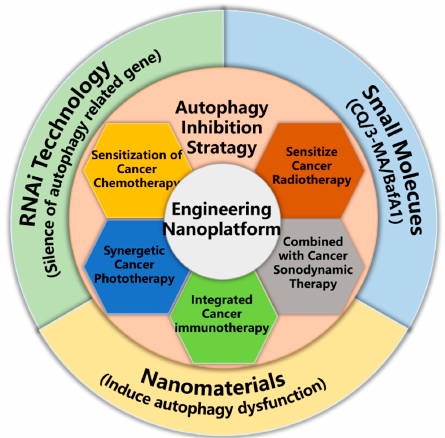
Scheme 1. Schematic diagram of nanoplatform-mediated complementary autophagy